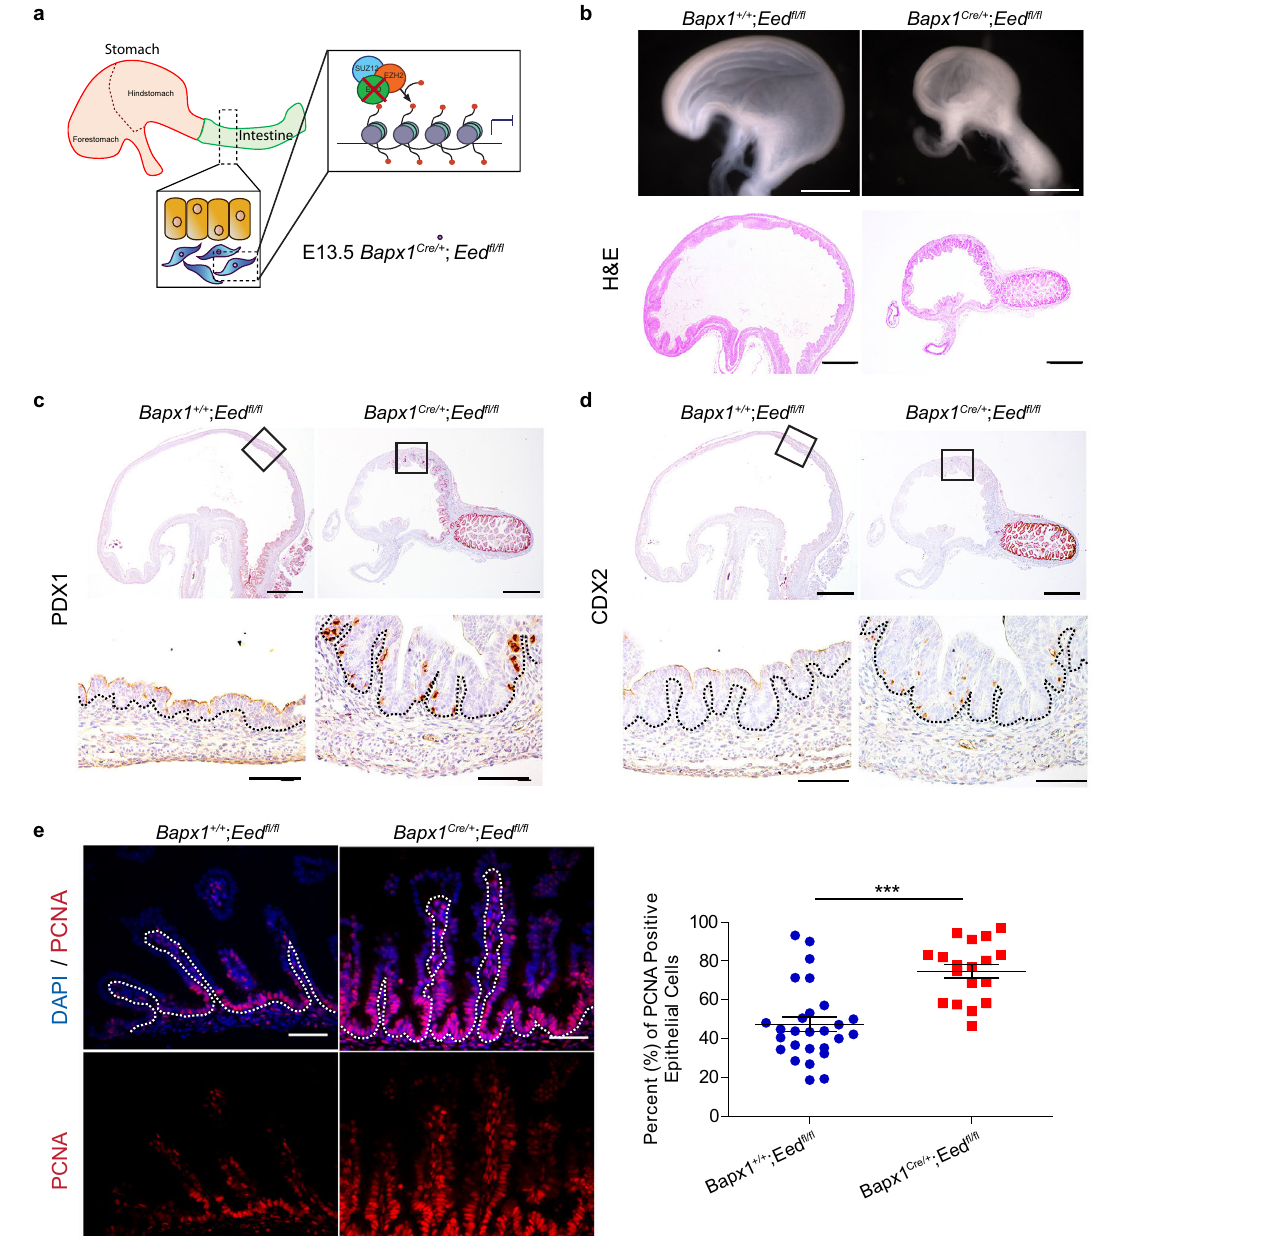
Fig. 2 | Mesenchymal loss of PRC2 disrupts GI epithelial fate and function. a Diagram of mesenchymal PRC2 ablation ( Bapx1 Cre/+ ; Eed fl / fl ). b Whole mount ima- ging (top), and Haematoxylin and Eosin staining (bottom) of KO and control mice ( Bapx1 +/+ ; Eed fl / fl )atE17.5. c , d ImmunohistochemistryagainstPDX1( c )andCDX2( d ) shows expression of both markers in the epithelial layer of the proximal hind- stomach ( n =3 biologically independent samples for each genotype). e PCNA